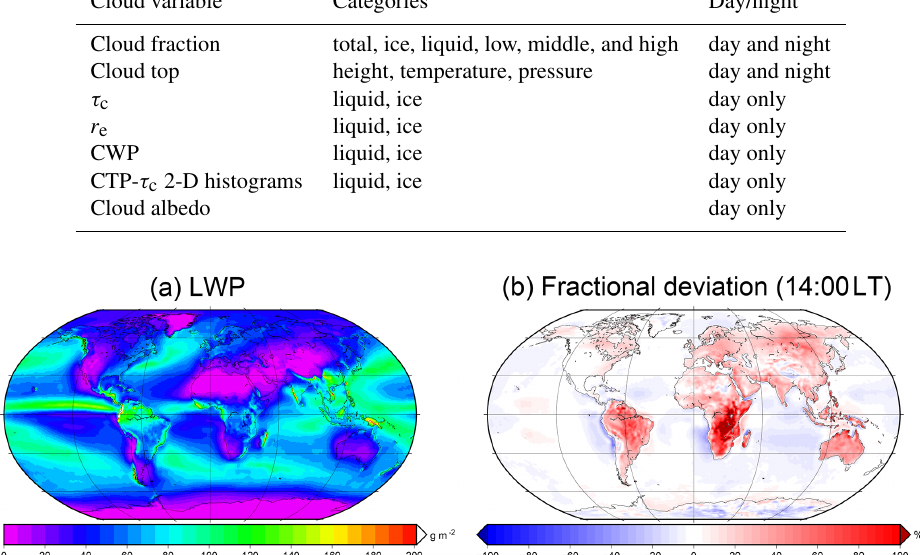
(cid:16) (cid:16) LWP (cid:17)(cid:17) − 1 14 100 × . The data are directly from the model from the period 1982 to LWP ref